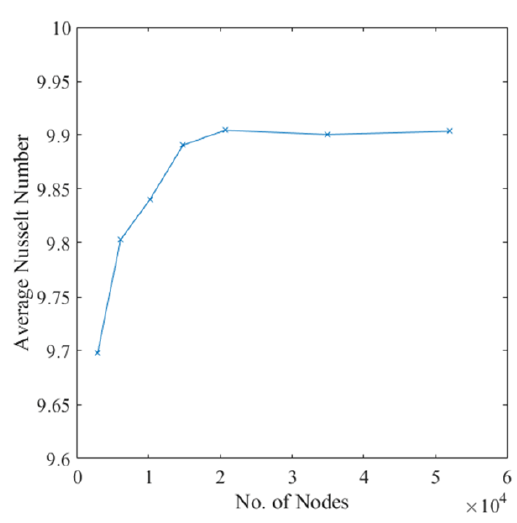
Figure 3. The plot of average Nusselt number versus number of